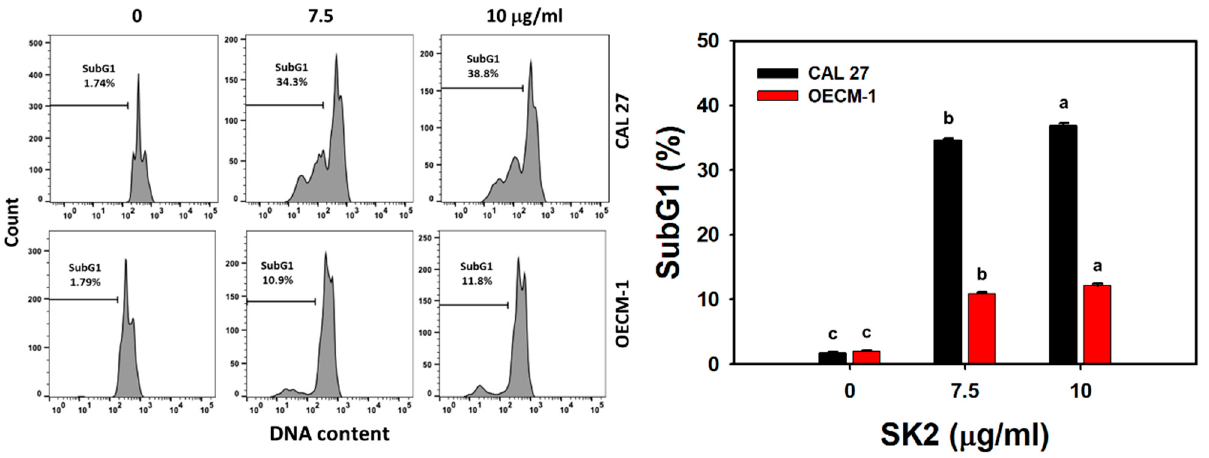
Figure 2. SK2 causes sub-G1 accumulation in oral cancer cells. DNA-content detections and statistics are provided. Cells were exposed to SK2 (0 (0.1% DMSO), 7.5, and 10 µg/mL) for 24 h. Data (means ± SDs; n = 3) without overlapping characters differed significantly ( p < 0.05). For an example of CAL 27 and OECM-1 cells, different concentrations with different characters produced significantly different results. For CAL 27 and OECM-1 cells, for SK2 at 0, 7.5, and 10 µg/mL, “c, b, and a” indicate significant differences because the results did not overlap.